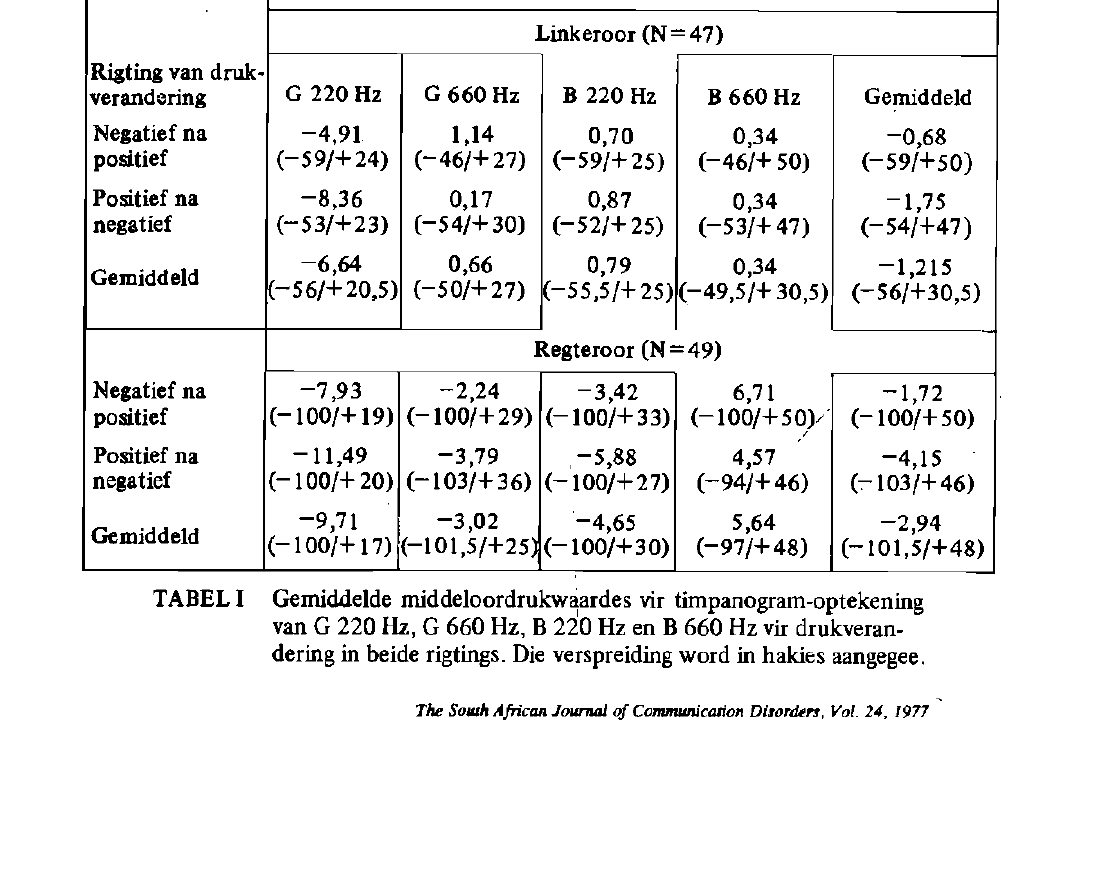
Gemiddelde middeloordrukwaardes vir